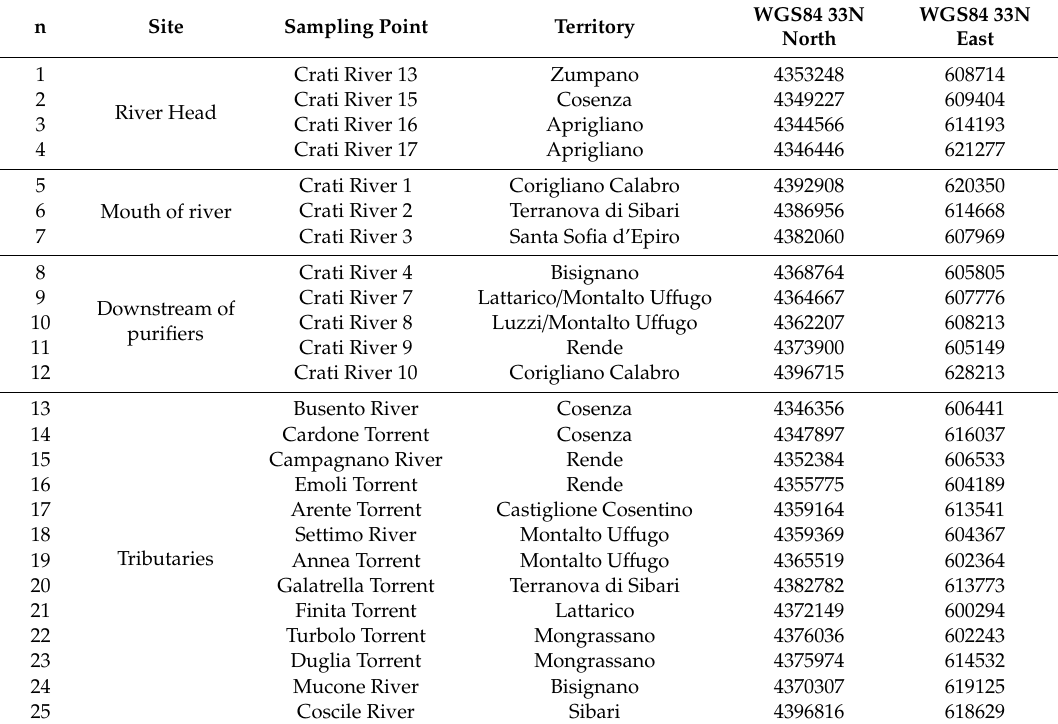
Table 1. Georeferencing of the sampling